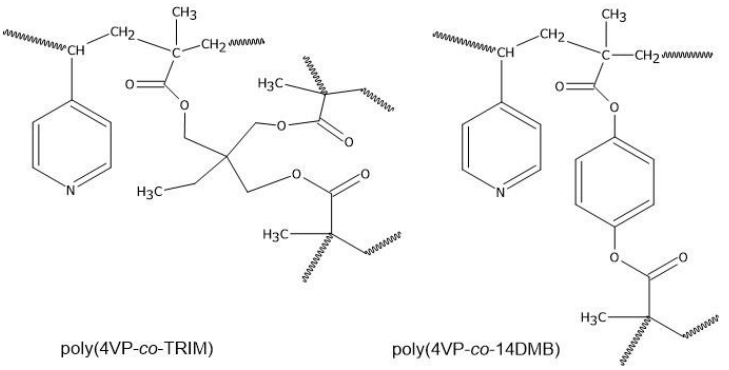
Figure 1. The schematic chemical structures of obtained 4VP